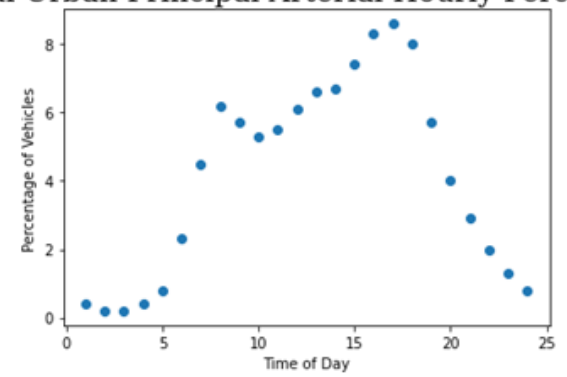
Figure 4. Plot of percentage vehicles vs. time of day.